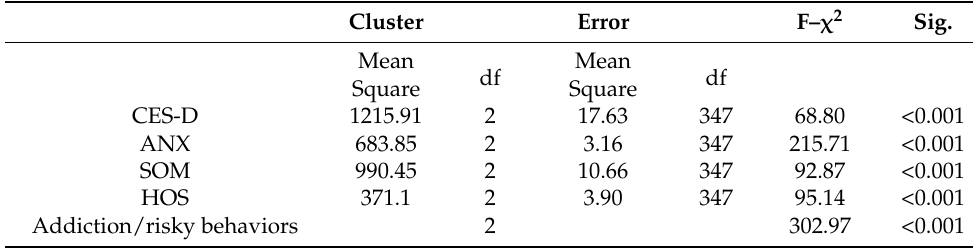
Table 4. Cluster analysis: ANOVA and chi-squared